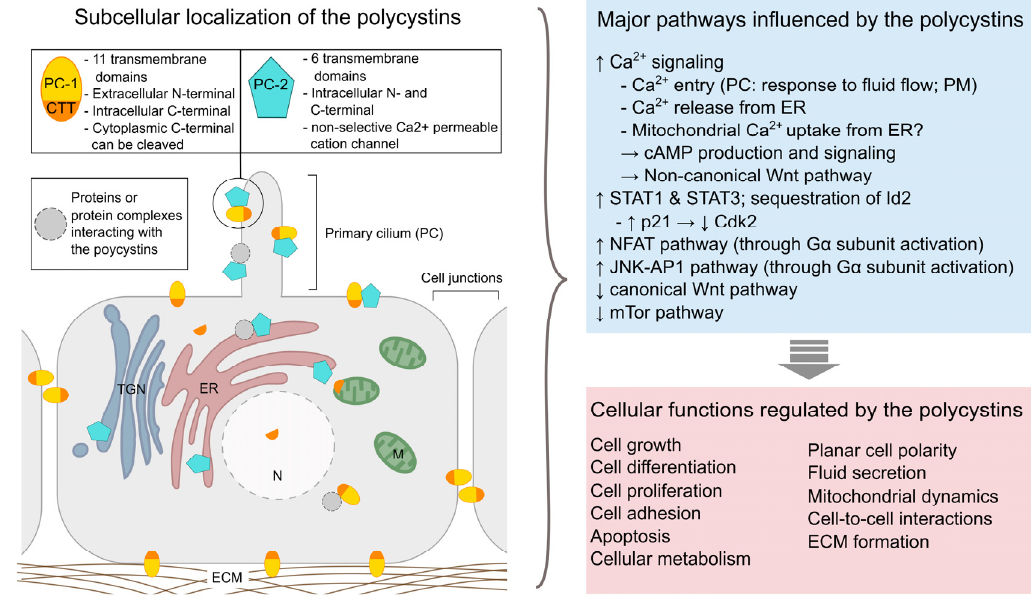
Figure 1. Overview of the subcellular localization of polycystins ( left ) and examples of major pathways and cellular functions influenced by these proteins ( right ). PC-1: polycystin-1; PC-2: polycystin-2; CTT: C-terminal tail (of polycystin-1); ECM: extracellular matrix; ER: endoplasmic reticulum; M: mitochondrion; PC: primary cilium; PM: plasma membrane; TNG: trans-Golgi network. [19,21–26].